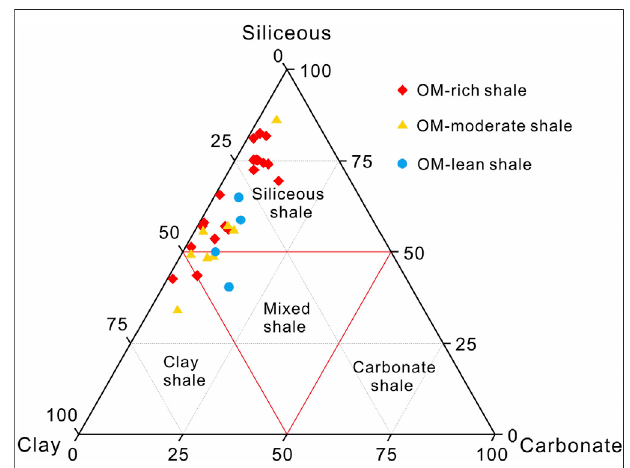
FIGURE 2 | Ternary plot of mineral compositions of the Longmaxi Formation in the northern Guizhou